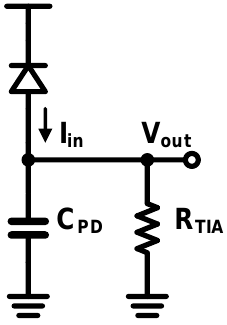
Figure 21. Simple implementation of TIA using single resistor.